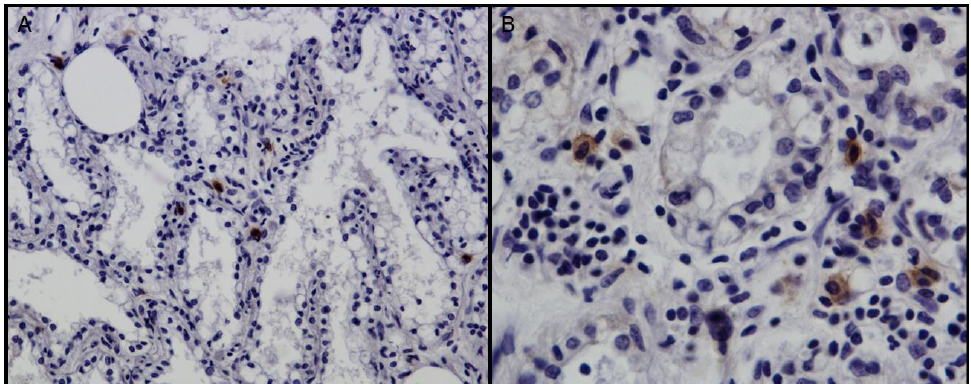
Figure 2. IHC against p28 of CAEV/VMV in mammary gland. ( A ) Scattered positive cells within minimal inflammatory lesions (+). 20×. ( B ) Positive macrophage-like cell in moderate lesion (++). 40×.